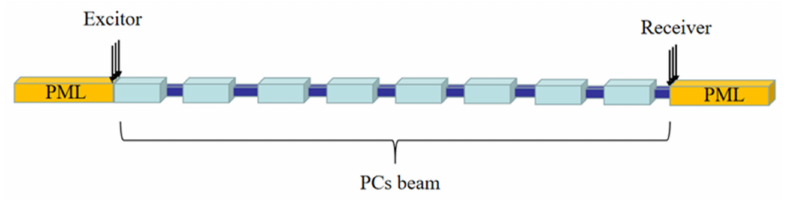
Figure 11. The transmission FEM model.